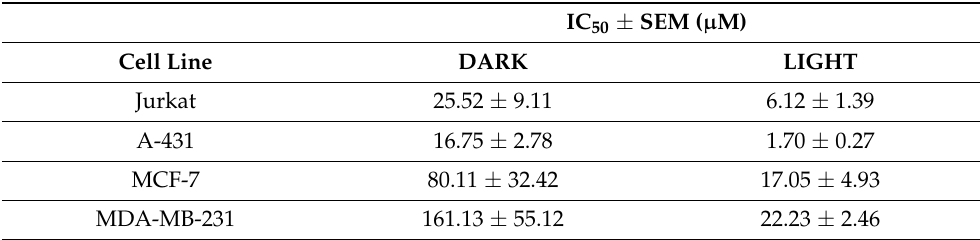
Table 1. IC 50 values, indicated as mean ± SEM (standard error of the mean), calculated after incubation with doxorubicin for 2.5 h followed or not by 30 min light irradiation and 24 h recovery in drug-free complete